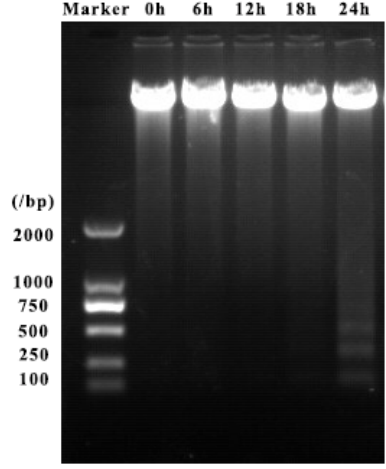
Figure 5. Agarose gel electrophoresis analysis of Sf9 cells’ genomic DNA with different treatments. The cells were treated with 7.5 μ g/mL ZC-14 for 0, 6, 12, 18 and 24 h, respectively.